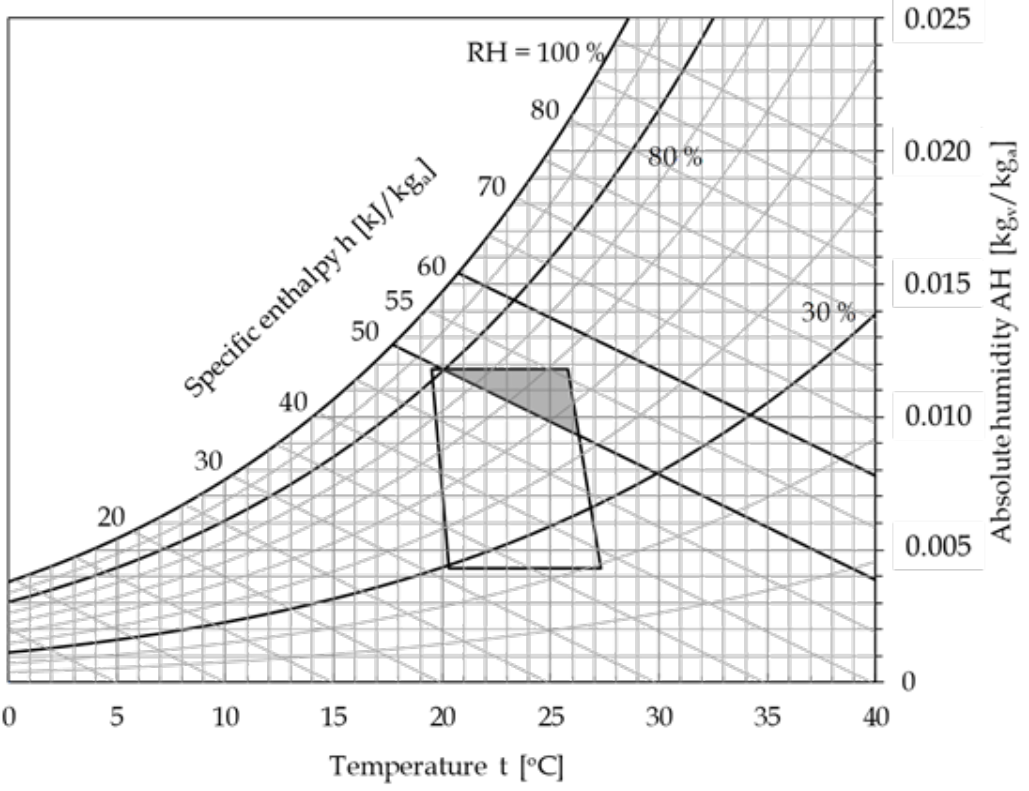
Figure 4. Optimal thermodynamic conditions of moist air to be ensured in indoor spaces to reduce the exposure risk.